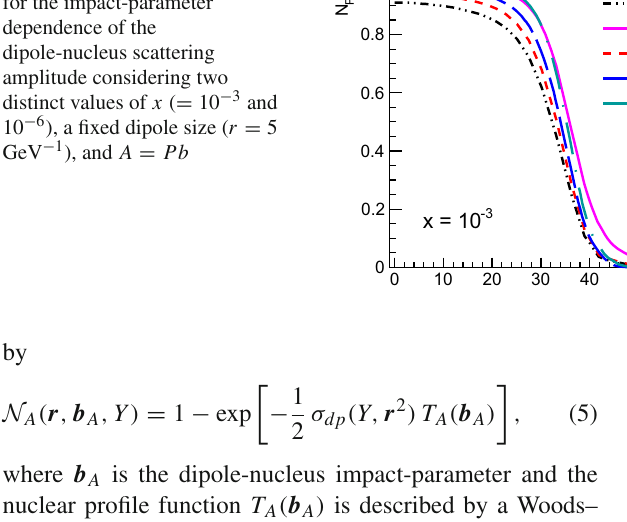
Fig. 3 Predictions of the different nonlinear approaches for the impact-parameter dependence of the dipole-nucleus